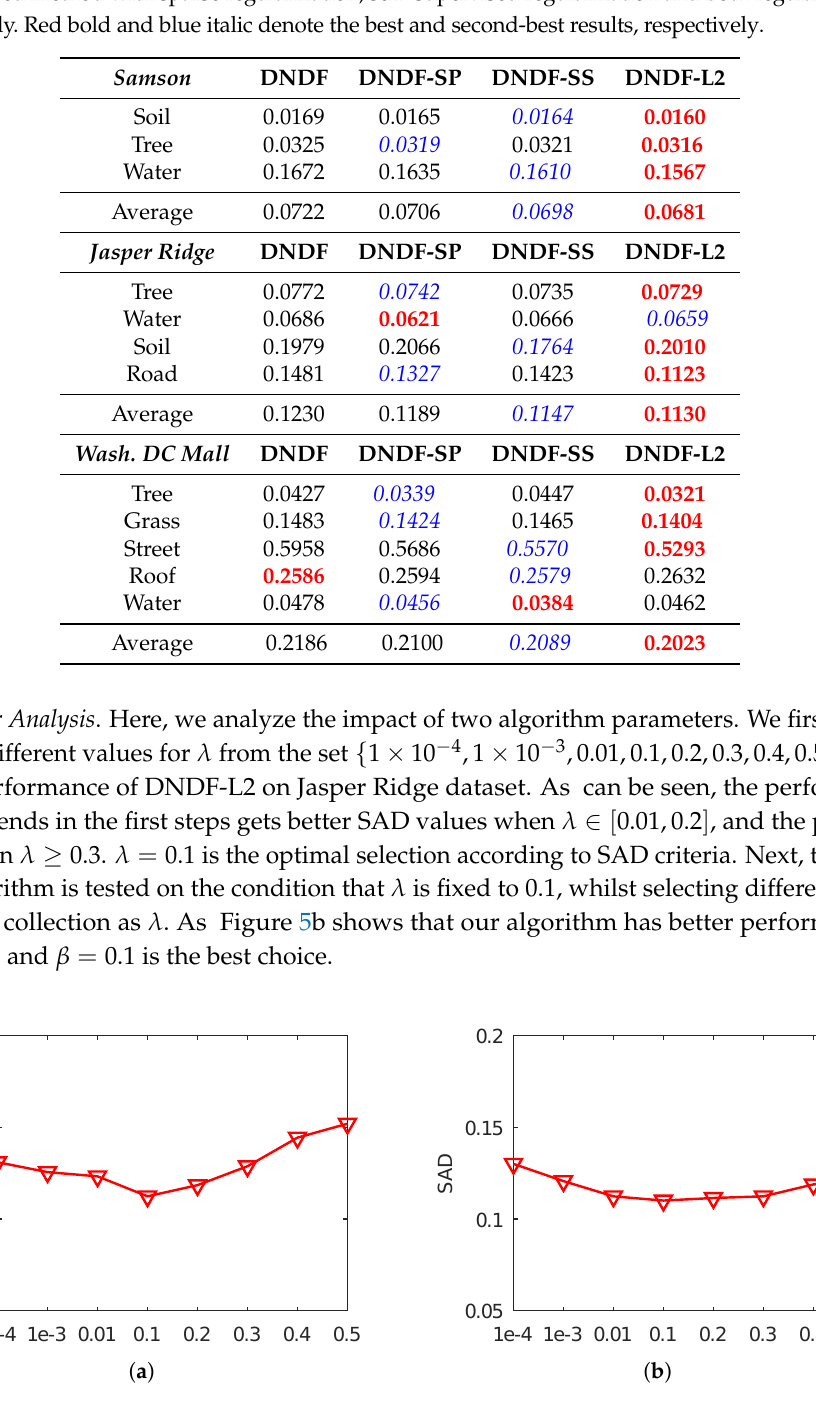
Figure 5. Algorithm parameter analysis on Jasper Ridge . ( a ) Parameter λ ; ( b ) Parameter β